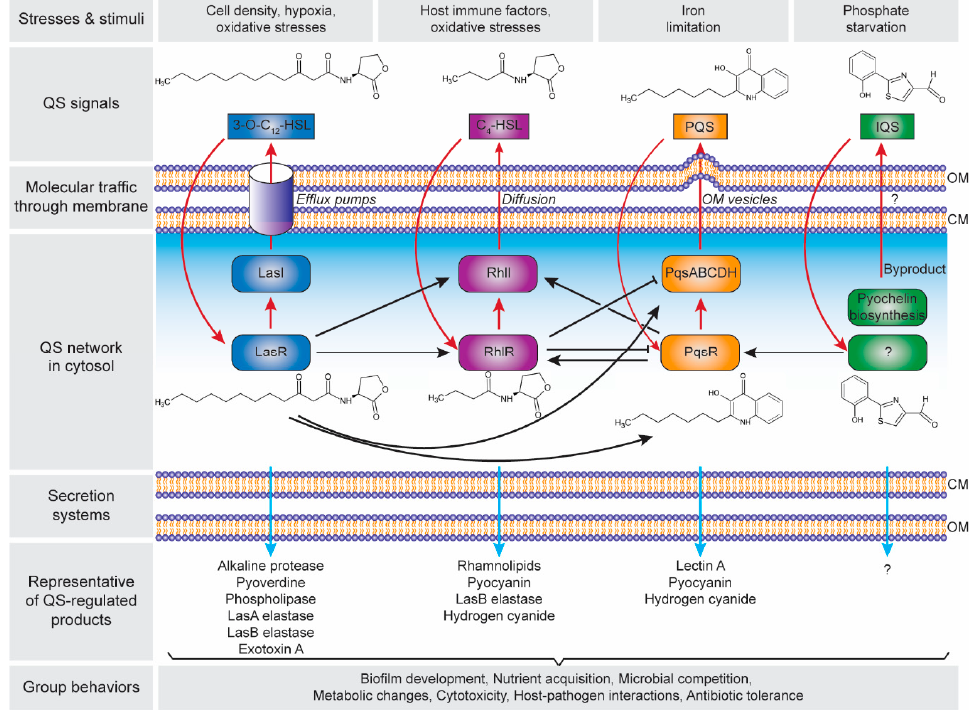
Figure 2. Hierarchical quorum-sensing (QS) network in Pseudomonas aeruginosa . The four QS pathways are activated in response to the cell density and environmental stimuli, with four autoinducer synthases including LasI, RhlI, PqsABCDH and AmbBCDE that produce N -3-oxo- dodecanoyl- ʟ -homoserine lactone (3O-C 12 -HSL), N -butyryl- ʟ -homoserine lactone (C 4 -HSL), 2-heptyl- 3-hydroxy-4-quinolone (PQS) and 2-(2-hydroxyphenyl)-thiazole-4-carbaldehyde (IQS), respectively. Note: the autoinduction is depicted in red arrows; the receptor for IQS is still unknown. The QS products are secreted through the cell membrane, that control the group behaviours and essential for the adaptation, survival and pathogenicity of P. aeruginosa . Abbreviation: CM, cytoplasmic membrane; OM, outer membrane. The Las, Rhl and PQS systems in the QS network of P. aeruginosa play important roles in the production of the functional elements that have an impact on biofilm development (Figure 2). These include rhamnolipid [97,98], pyoverdine [99], pyocyanin [100,101], Pel polysaccharides [102], and lectins [103,104]. Rhamnolipid is a rhamnose-containing glycolipidic compound (i.e., biosurfactant) that functions to preserve the pores and channels between microcolonies, enabling the passage of liquid and nutrients within mature biofilms. Pyoverdine can sequester iron in the environment and delivery it to the cell which is an essential component for biofilm development. In an environment where iron is limited, twitching motility is more favoured than sessile growth and thus inhibiting biofilm formation [105]. Pyocyanin is a secondary metabolite with a cytotoxicity effect, thereby inducing cell lysis and releasing the cells’ DNA to extracellular space (i.e., eDNA–one of the biofilm components). Pyocyanin can bind to the eDNA and causes an increase in solution viscosity, thus also increasing the physicochemical interactions between biofilm matrices and the surrounding environment as well as promoting cellular aggregation. Pel polysaccharides can also interact with eDNA through cationic-anionic interactions within the biofilm matrix, strengthening the biofilm structure. Lectins are soluble proteins located in the outer membrane which consist of two forms, i.e., LecA (that binds to galactose and its derivatives) and LecB (that binds to fucose, mannose and mannose-containing oligosaccharides). Such adhesive properties of lectins facilitate the retention of